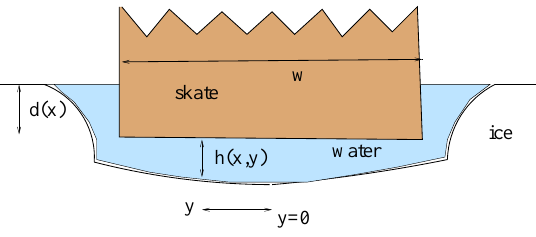
Figure 2: transverse cross-section in the y , z plane of the skate and the layer of water under- neath. Note that, for visibility, width (mm) and depth ( µ m) are not drawn in proper scale.